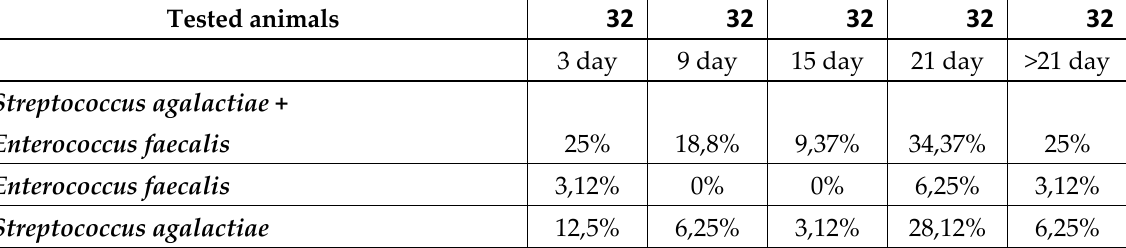
Table 1. Incidence of the species Streptococcus agalactiae and Enterococcus faecalis isolated from uterine